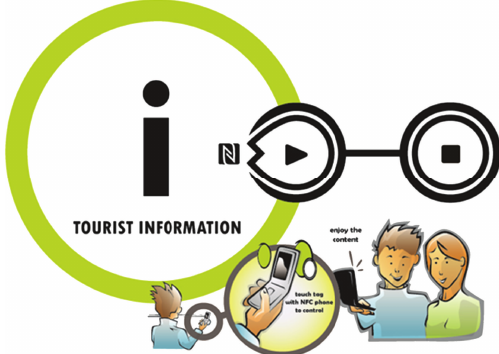
Figure 5: A multimedia player service for a tourist